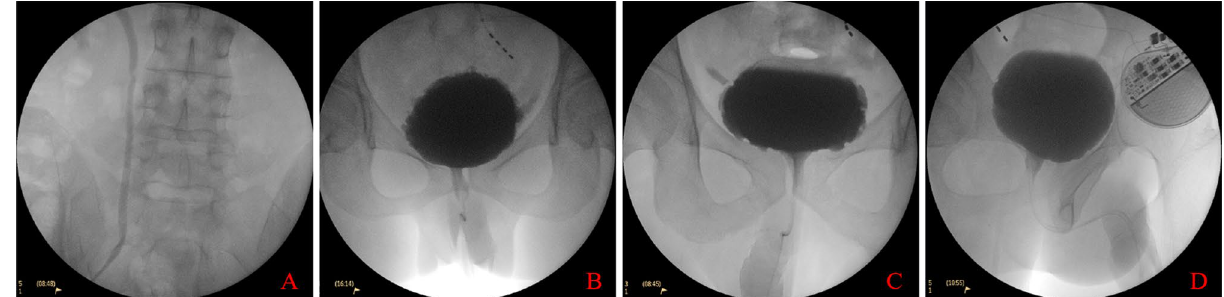
Figure 1. Schematic diagram of urodynamics X-ray views of 2 patients with neurogenic bladder. ( A,B ) Baseline and testing phase of the same patient, and ( A ) grade II vesicoureteral reflux (VUR) in the right ureter during storage at baseline; ( B ) no VUR in right ureter during storage in the testing phase; ( C,D ) testing phase and follow-up phase of the same patient, and ( C ) grade I VUR in right ureter during storage in the testing phase; ( B ) no VUR in right ureter during storage in the follow-up